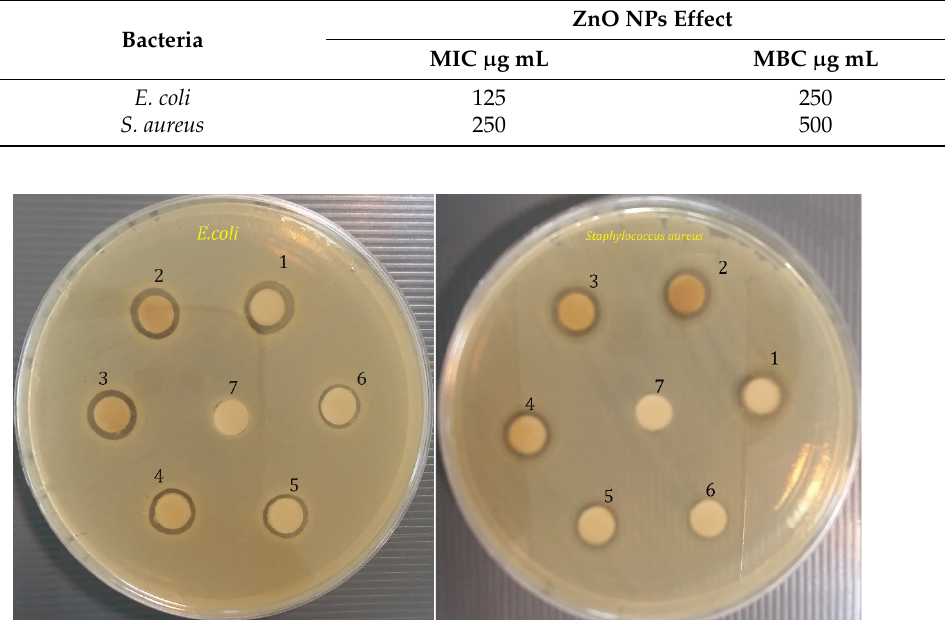
Figure 7. Zone of inhibition produced by green-synthesized ZnO-NPS against bacterial strains: E. coli and S. aureus . 1: Chloramphenicol (positive control), 2: 2000 ( μ g/mL), 3: 1000 ( μ g/mL), 4- 500 ( μ g/mL), 5: 250 ( μ g/mL), 6: 125 ( μ g/mL), 7: Distillated water (Negative control).